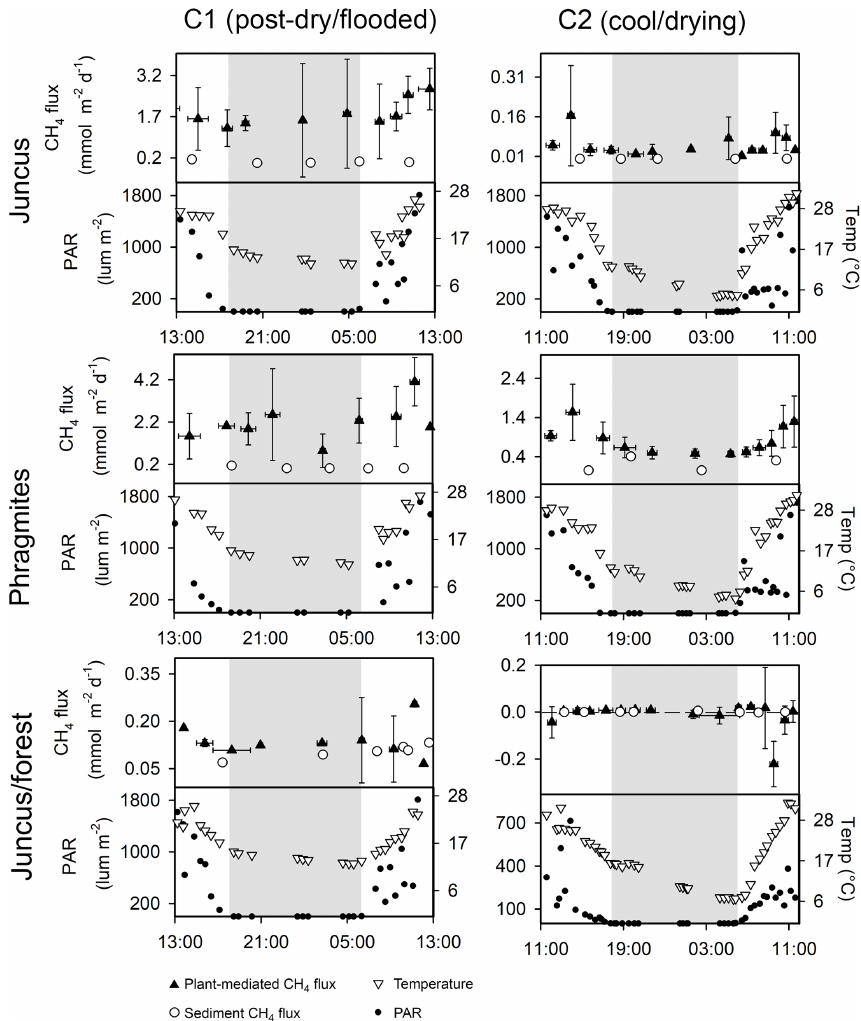
Figure 4. Simultaneous 24h time series of vegetative CH 4 fluxes from the seasonal wetland ecotypes at Cattai Wetlands during C1 (post-dry–flooded, April 2017) and C2 (cool–drying conditions, September 2017). The vertical error bars of the plant-mediated CH 4 flux (mmolm − 2 d − 1 ) represent the standard deviation of the triplicate time series measurements taken from each site, and the horizontal bars represent the total aggregated time period represented by replicate chambers. The grey shading indicates night-time. Note: different y axis scales for CH 4 to highlight diel